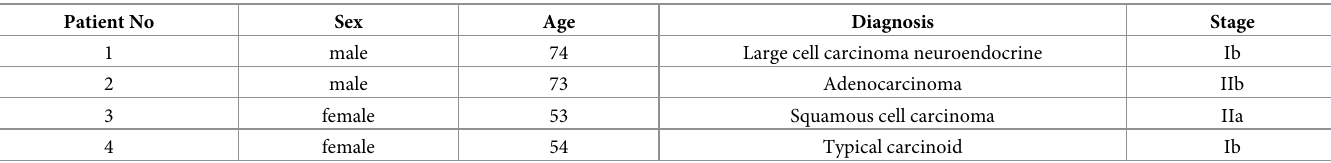
Table 1. Patients’ characteristics.